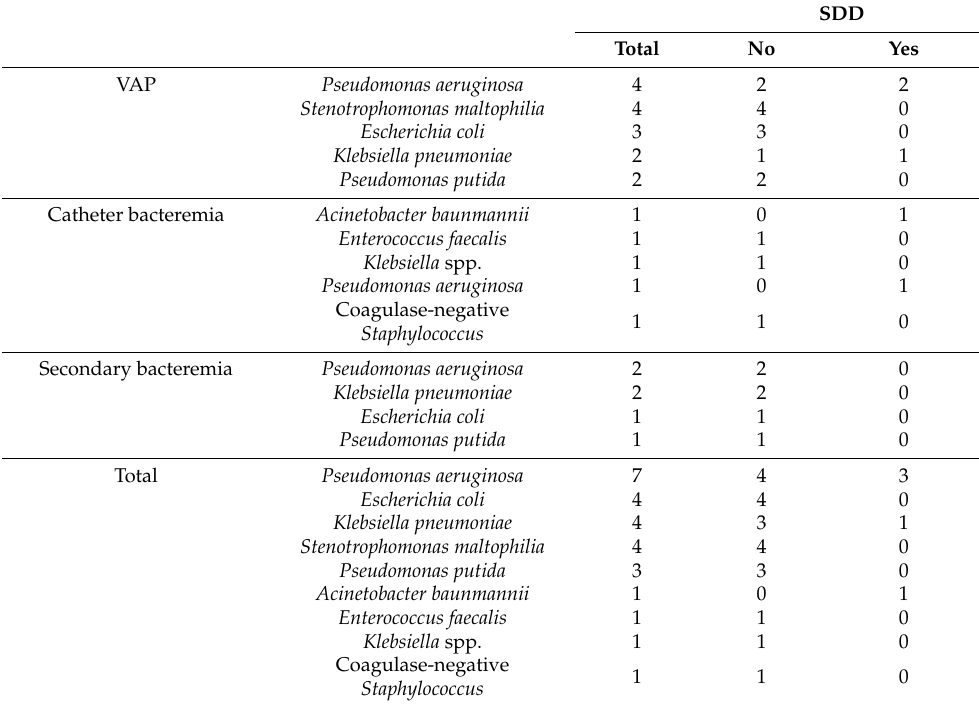
Table 3. Multiresistant germs according to the SDD regimen and by